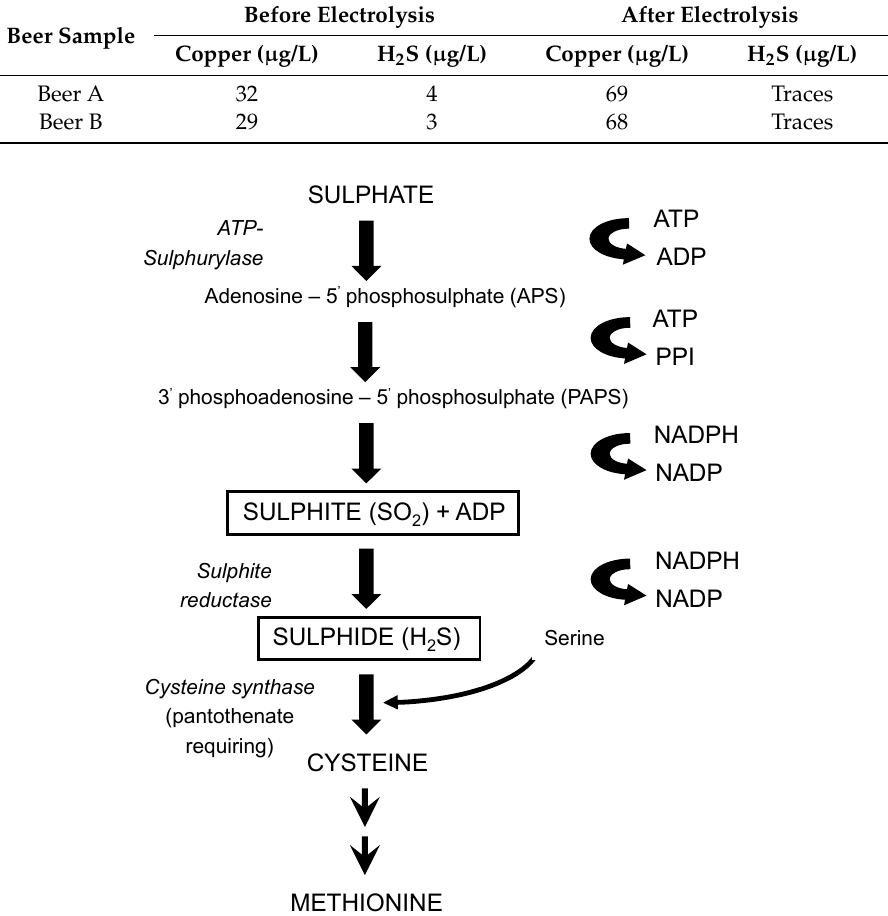
Figure 20. Pathway for the synthesis of sulfur-containing amino-acids [1].